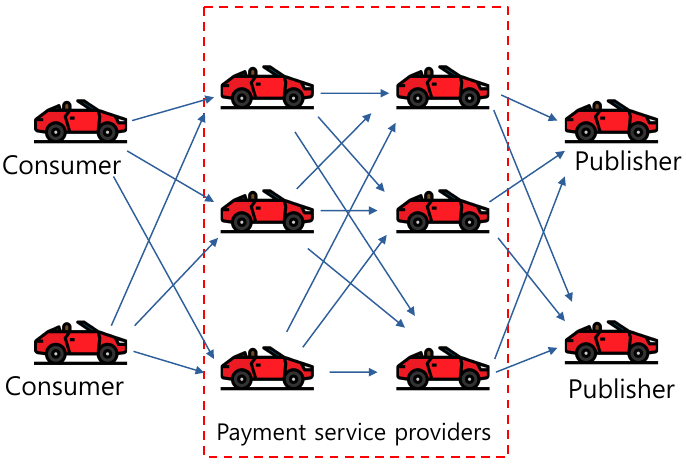
Figure 10. Multiple consumers and publishers with multi-hop autoCoin